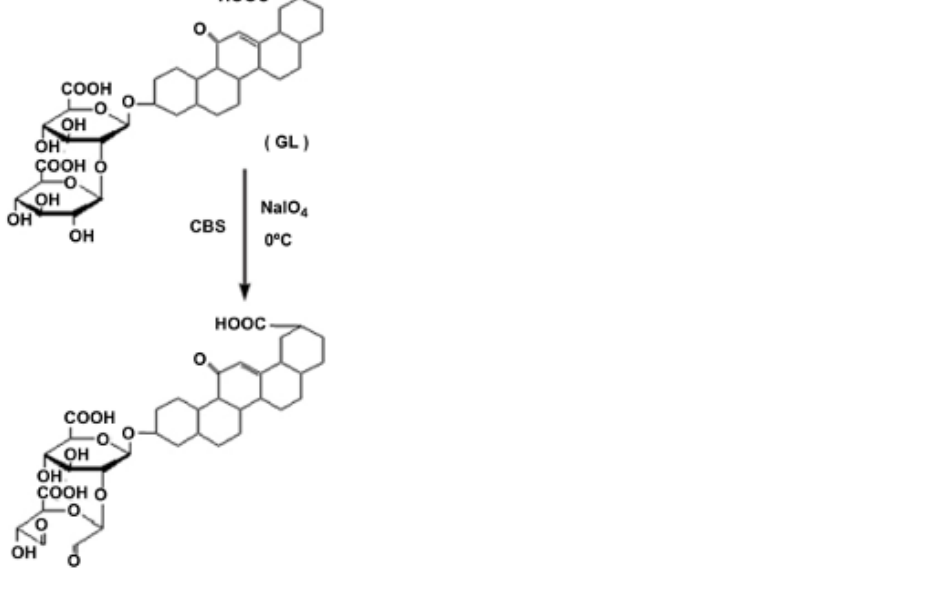
Figure 4. Oxidation reaction in carbonate buffered solution (pH 9.5) and cold sodium periodate solution (50 mM) to obtain the oxidized GL. Adapted with permission from [83], Elsevier, 2012 .